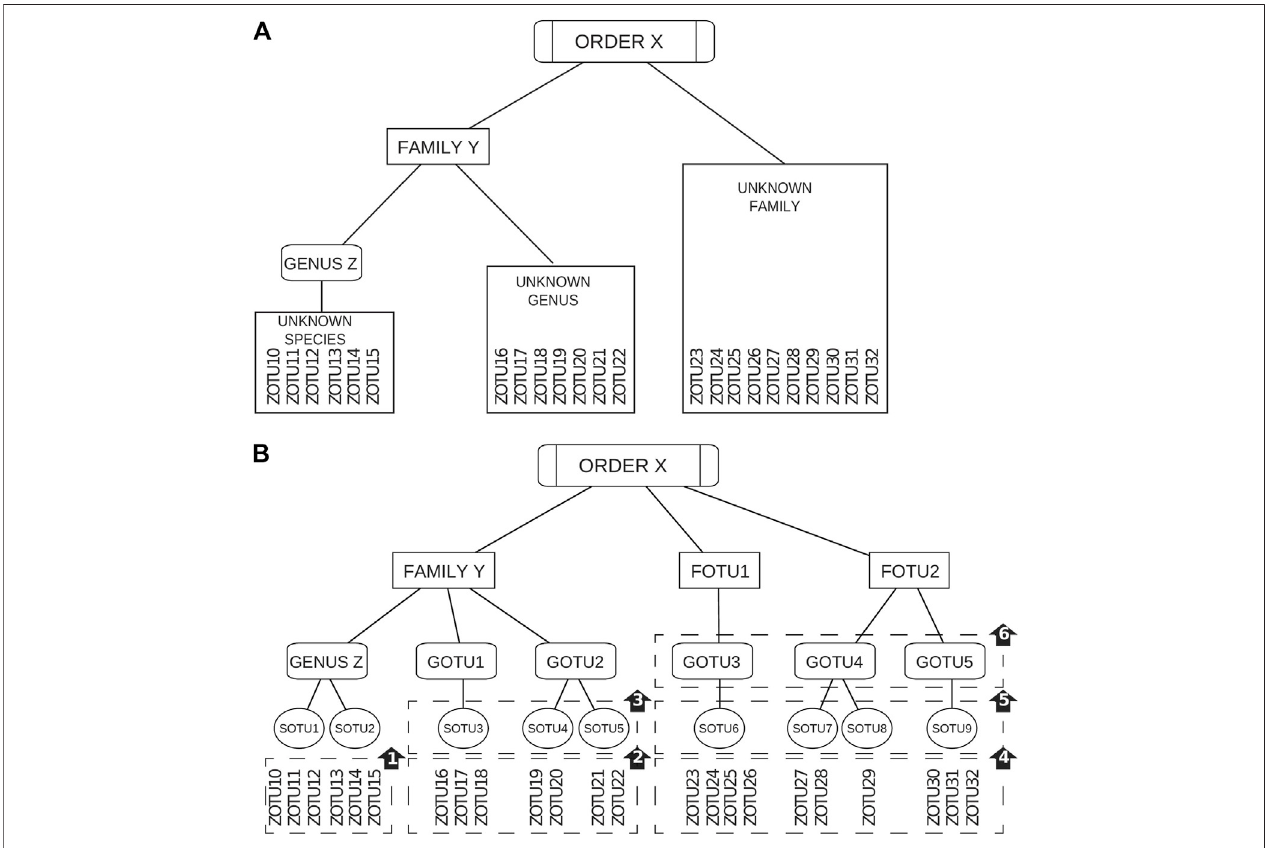
FIGURE 2 | Simpli fi ed representation of the TIC algorithm. (A) Sequences are divided based on their identi fi ed taxonomic level. (B) 1 ) Denoised sequences within the same genus are clustered to produce sOTUs. 2 ) Sequences of unknown genera within the same family are clustered into sOTUs. 3 ) Produced sOTUs are further clusteredintonovelgOTUs. 4 )Sequencesoftheunknownfamilyare fi rstclusteredintosOTUs. 5 )ThosesOTUsproducegOTUs. 6 )fOTUsareformedfromthegOTUsof an unknown